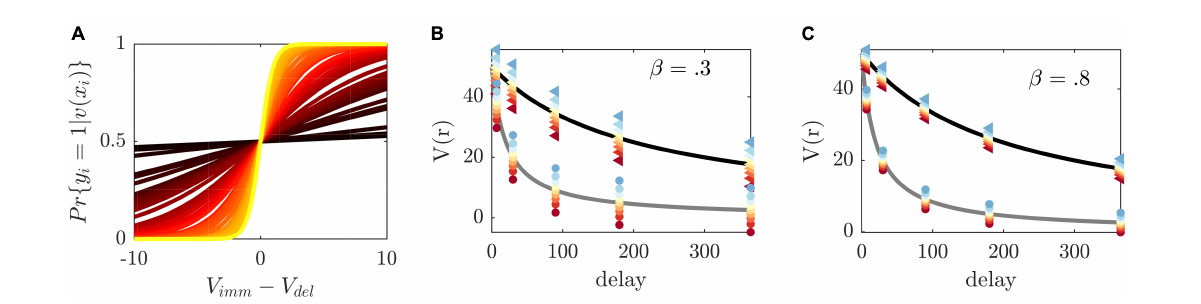
FIGURE2 Illustration of method principles. (A) Immediate choice probability [cf. Eqn. (2)] as a function of the difference between immediate and delayed value for β estimates in our sample (color-coded from largest β = 2 in yellow to smallest β = 0 . 01 in dark red). The indifference point, i.e., the point at which immediate and delayed choice probability (and immediate and delayed choice values) are equal, is at 0. If v imm / v del immediate choice probability is below/above 0.5. β regulates the steepness of the curve and thus the sensitivity toward differences in values. (B) Discounted value of a reward of size 50 ( y -axis) delayed at different time points ( x -axis) and two exemplary κ (cid:48) s ( κ = 0 . 005 in black and κ = 0 . 05 gray). The method’s selected immediate rewards at a given delay are displayed as colored dots from blue to red with respect to the induced choice probability from 0.1 to 0.9 (triangles/circles are associated with κ = 0 . 005/0.05, respectively). To induce the same probabilities at different delays, the difference between the presented immediate choice values (depicted as colored dots) and delayed values (depicted on the discounting curve) is constant [see Eqn. (2), v del − v imm ]. For participants with different κ , the reward and value ratios will therefore vary. The left graph depicts selected rewards for a hypothetical β = 0 . 3 and (C) the right graph for β = 0 . 8. β thus regulates the precise difference between immediate and delayed values, with higher β resulting in smaller differences, making the differentiation between the two more